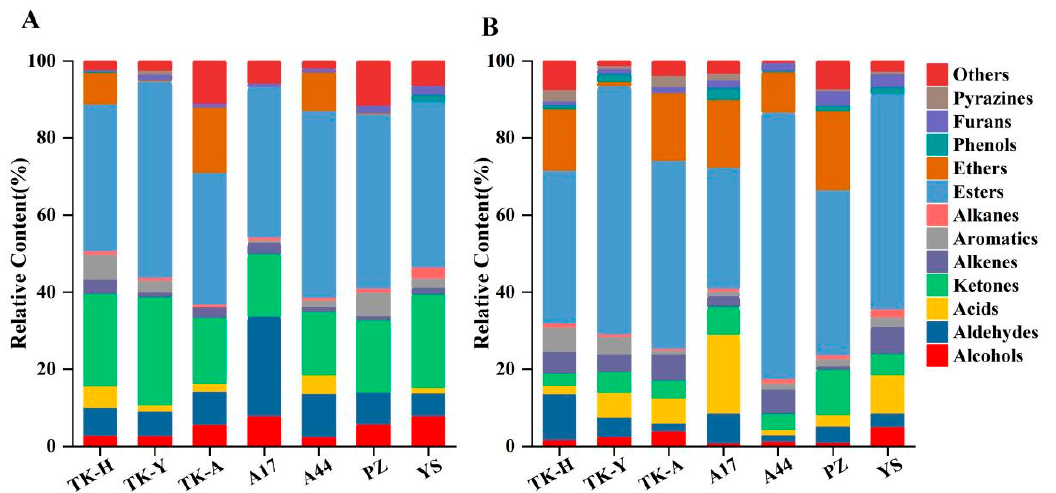
Figure 2. The relative content of volatile chemical groups in different varieties detected by HS- SPME/GC–MS: ( A ) was detected in Taraxacum leaves; ( B ) was detected in Taraxacum roots.